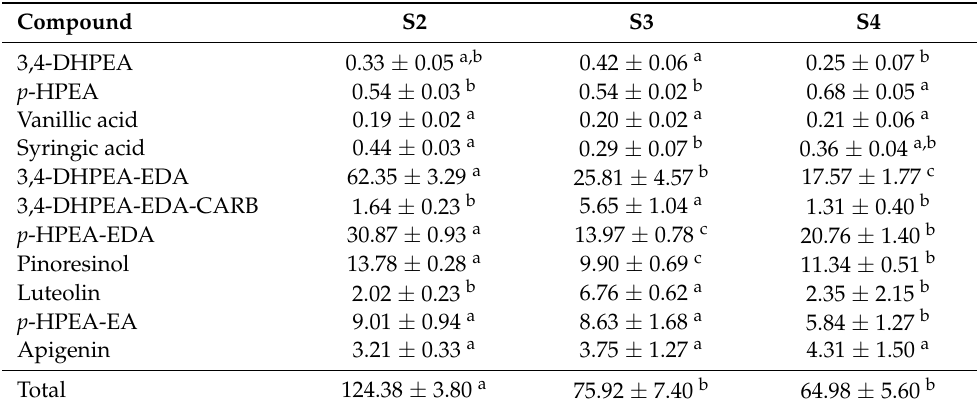
Table 4. Identified phenolic compounds (mg GAE kg − 1 ) of the Oliva Rossa VOOs extracted during fruit ripening in the 2017/2018 harvest season (mean ± SD, n =